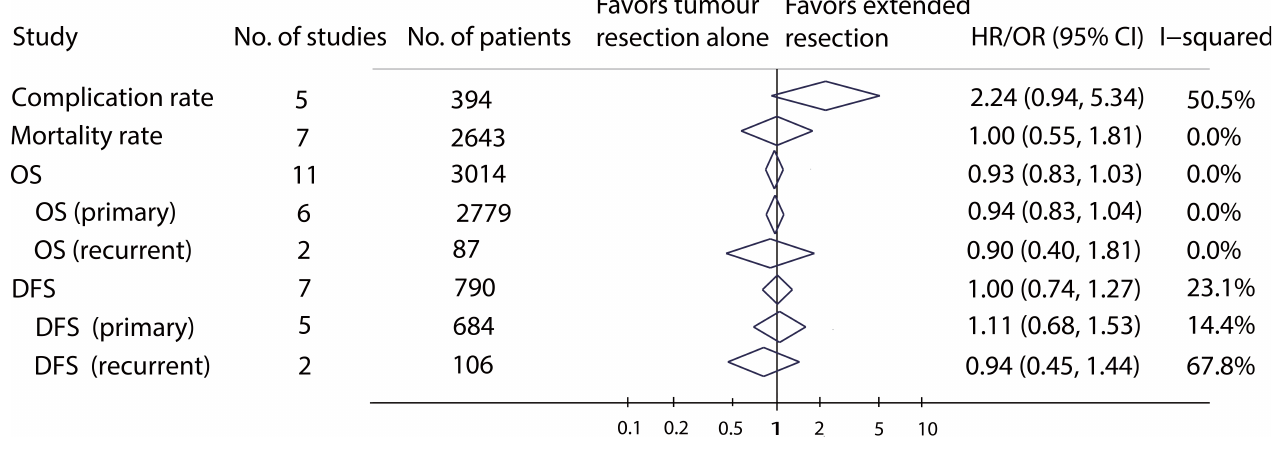
Fig 2. Meta-analysis results of extended resection versus tumour resection alone.